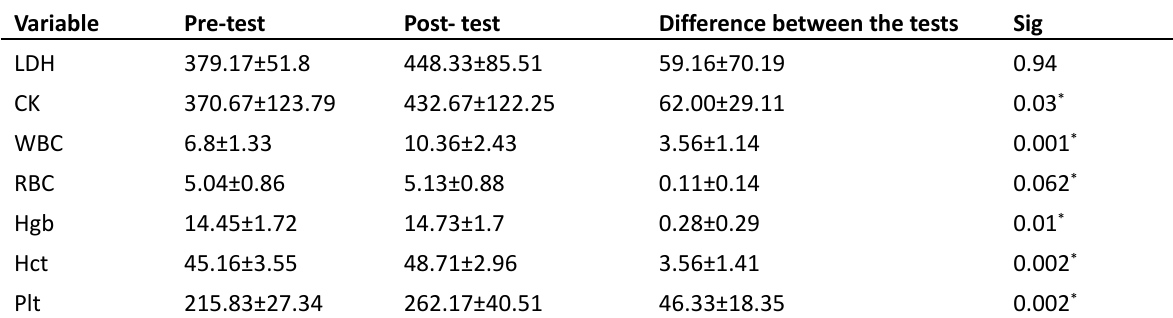
SigDifference between the testsPost- testPre-testVariable